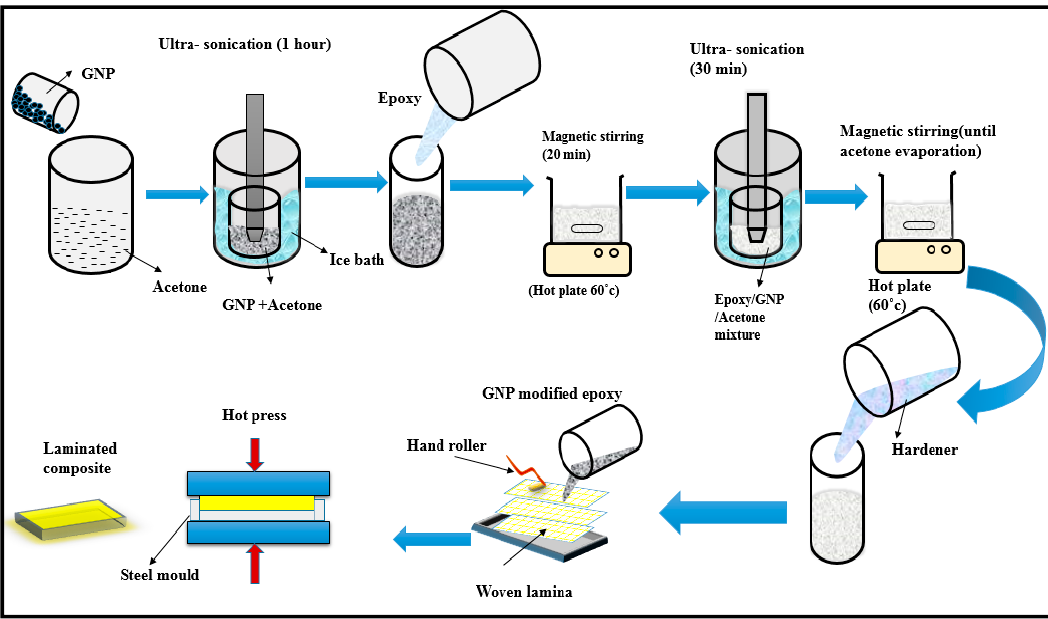
Figure 2. GNP incorporation into epoxy and fabrication of laminates [39].